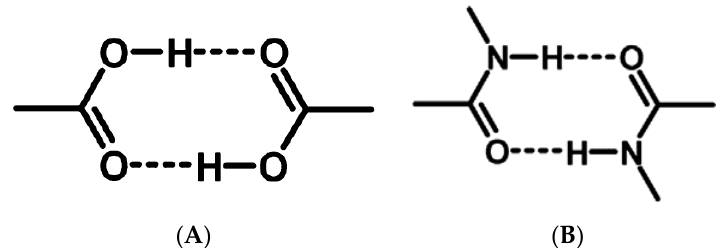
Figure 5. Schematic representation of supramolecular homosynthons ( A ) acid-acid dimer and ( B ) amide-amide dimer [34,55] [Reprinted from [55] with permission. Copyright 2014 American Chemical Society].